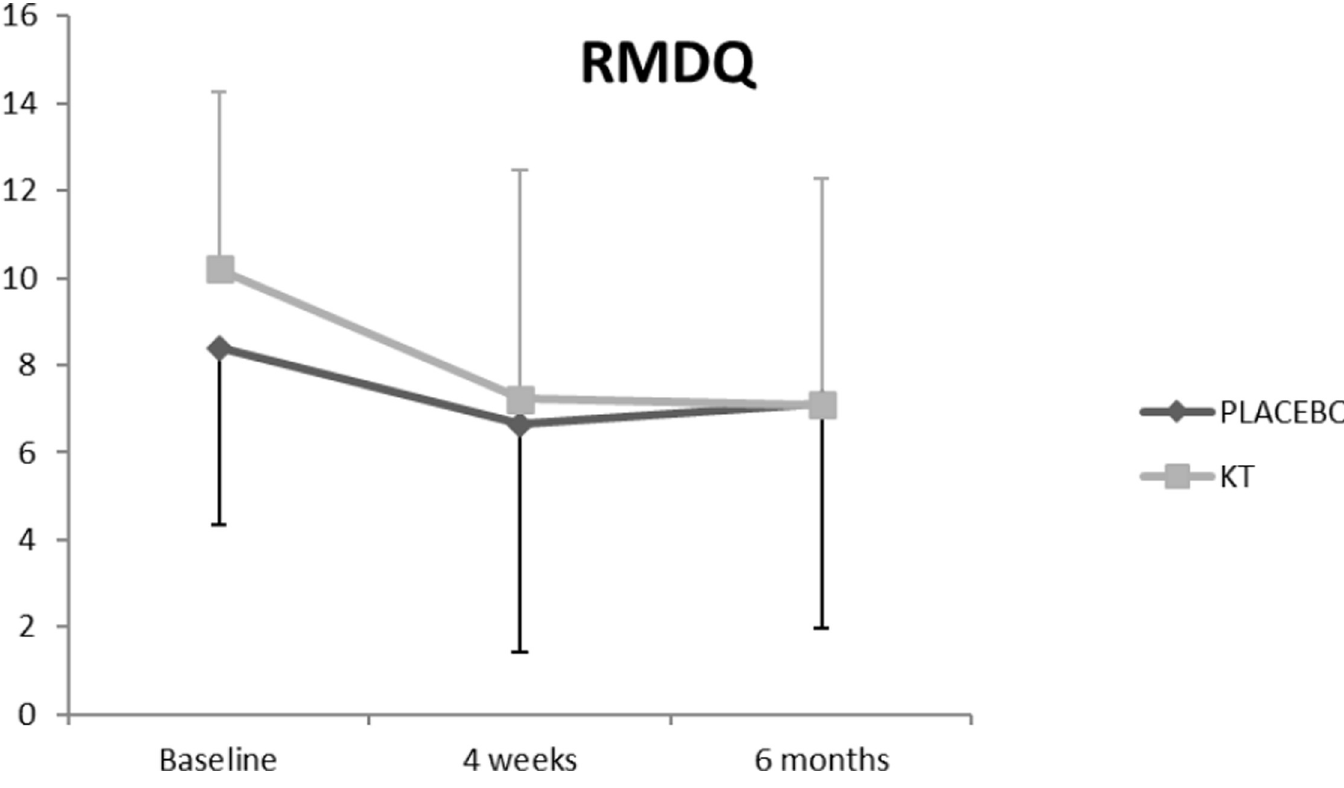
Fig 4. Effects of the intervention on RMDQ.